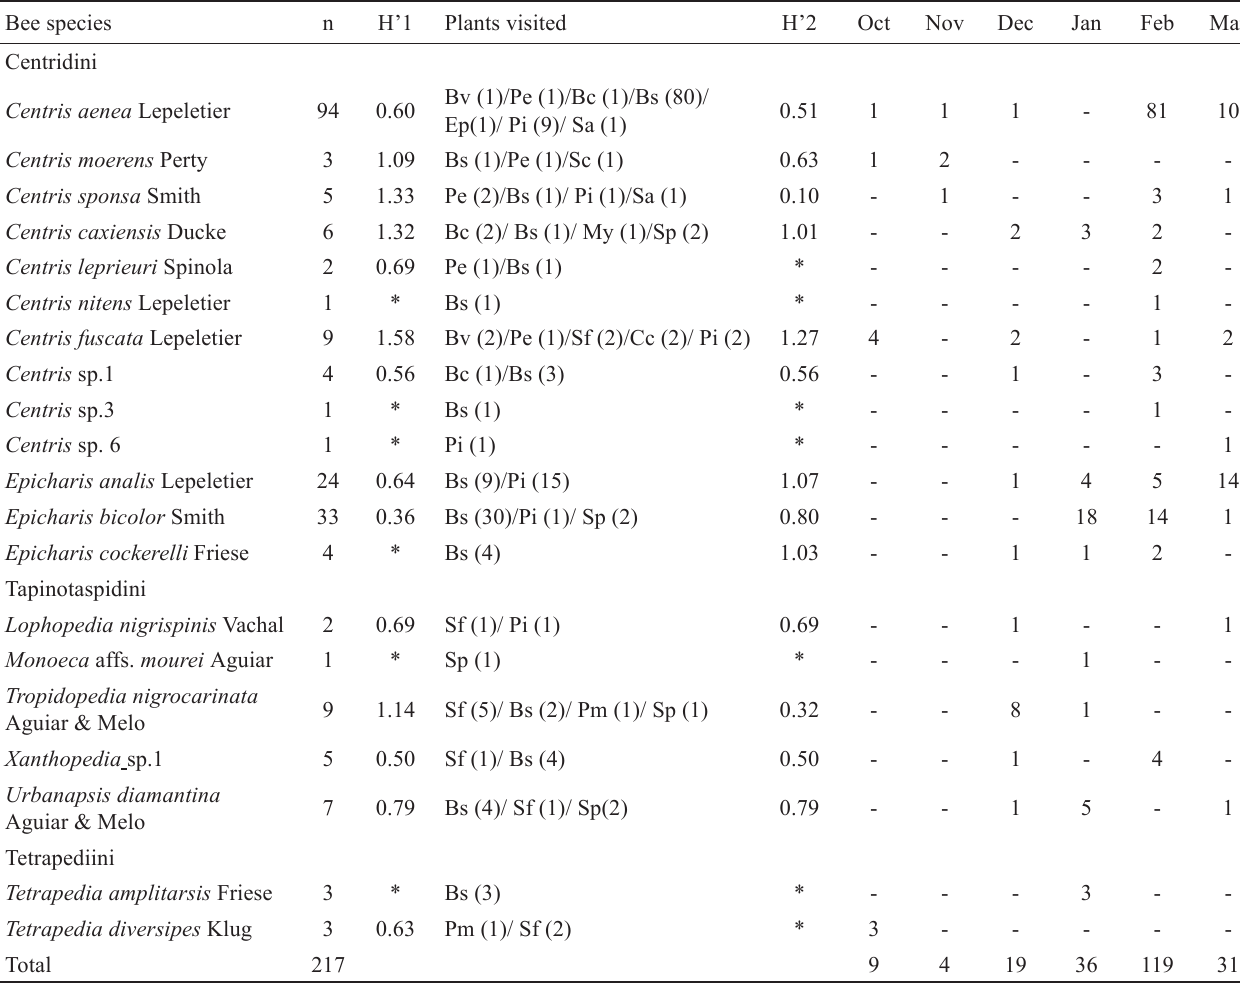
Table 1. Abundance of oil-collecting bee species (n), trophic niche width (H’1) (Shannon index), temporal niche width (H’2), and plant species visited for floral resources in a savannah area in the Chapada Diamantina, Brazil. Number of flower-visiting bees captured in each plant species in brackets. * Bee species collected in a single plant or month. Bv: Bowdichia virgilioides , Cc: Centrosema coriaceum , Pm: Periandra mediterranea , Pi: Pityrocarpa moniliformis (Fabaceae)/ Bc: Byrsonima cydoniifolia , Bs: Byrsonima sericea , Sp: Stigmaphyllon paralias (Malpighiaceae)/ Ep: Eugenia cf. punicifolia (Myrtaceae), My: Myrtaceae sp.1/ Pe: Passiflora edulis (Passifloraceae)/ Sf: Serjania faveolata (Sapindaceae)/ Sa: Simarouba amara (Simaroubaceae)/ Sc: Stachytarpheta crassifolia